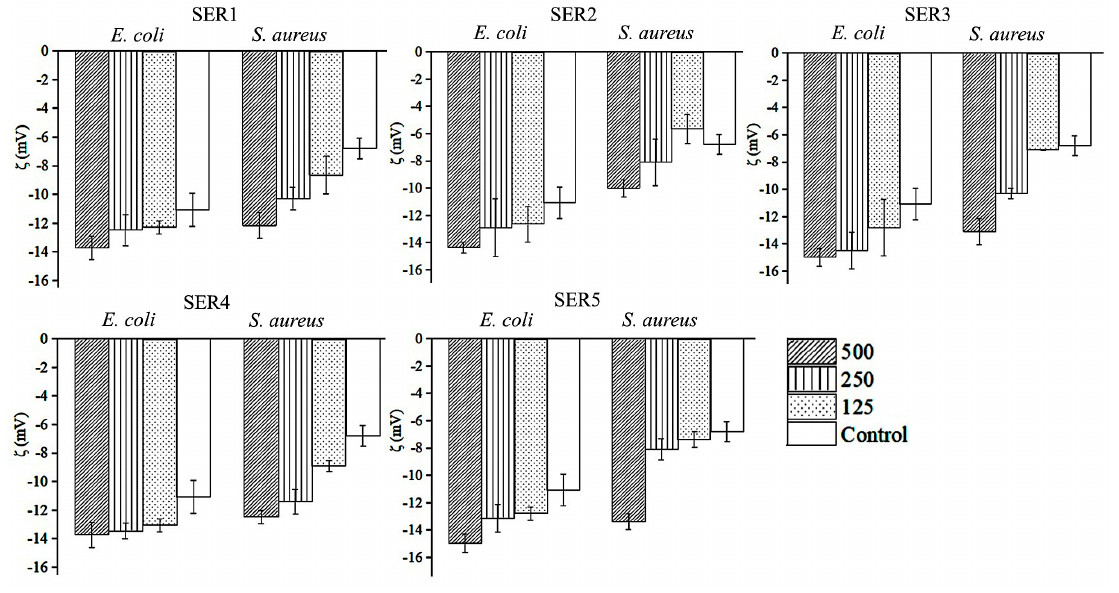
Figure 6. Effect of treatment of Cu-SER MOFs on bacterial cell surface zeta potential of Staphylococcus aureus and Escherichia coli .